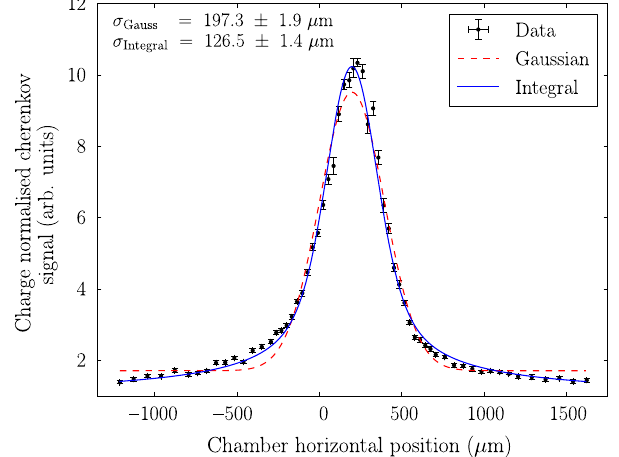
FIG. 18. Comparison of Gaussian and overlap integral models for the horizontal laserwire scan.